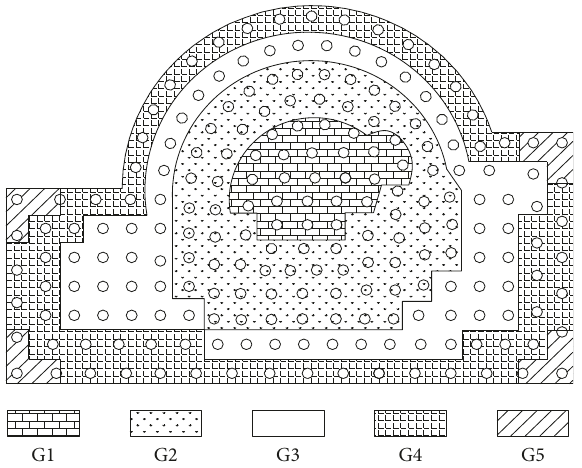
Figure 13: Final optimized configuration with different pile spacing (scheme 2).